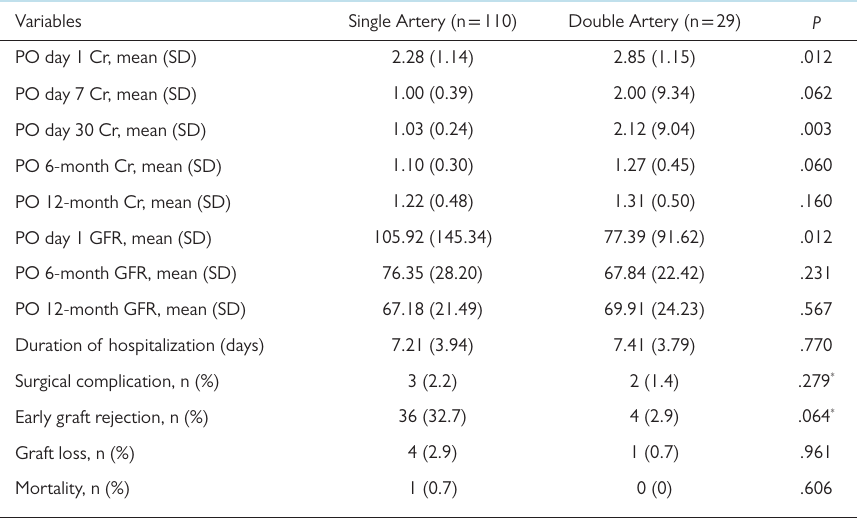
Table 3. Comparison Regarding Postoperative Outcomes Variables Single Artery (n = 110) Double Artery (n =